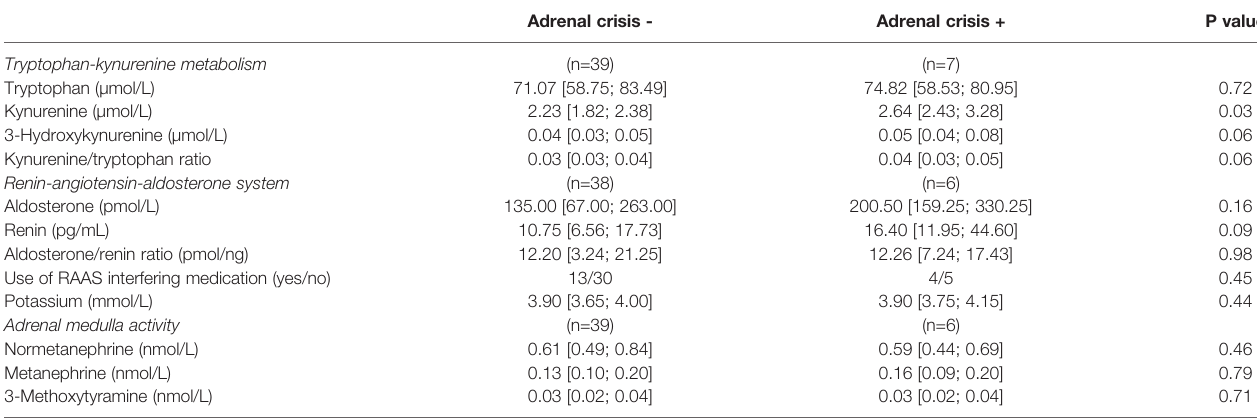
TABLE 5 | Total serum levels of tryptophan, kynurenine, and 3-hydroxykynurenine, kynurenine to tryptophan ratio, aldosterone, renin and metanephrines in patients on the lower dose hydrocortisone (0.2-0.3 mg/kg/day) with or without a history of an adrenal crisis.